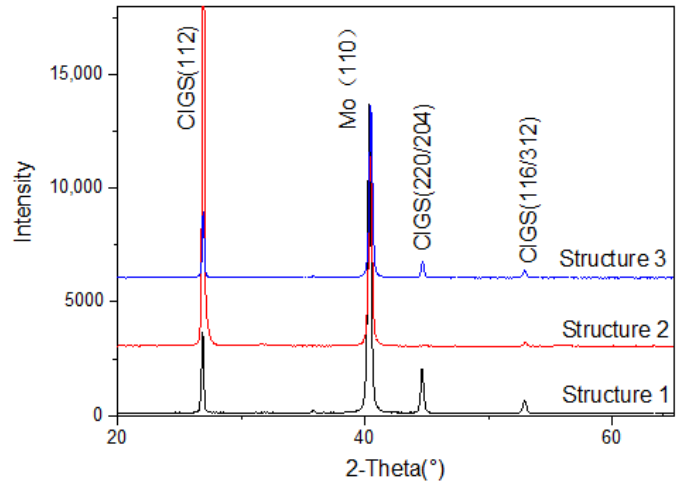
Figure 3. XRD patterns of annealed